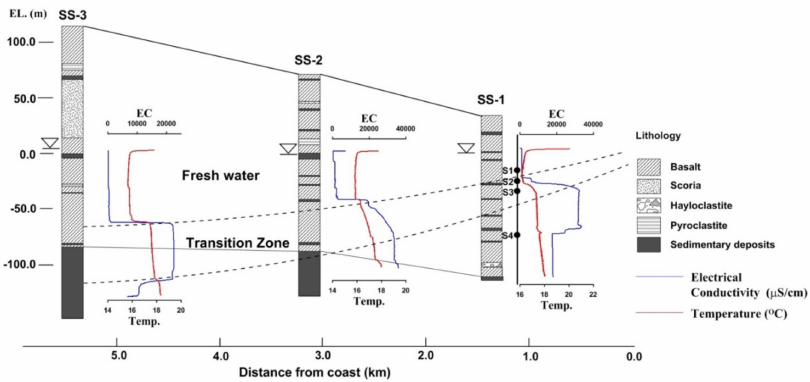
Figure 3. Lithology and groundwater temperature and electrical conductivity (EC) logs in the monitoring